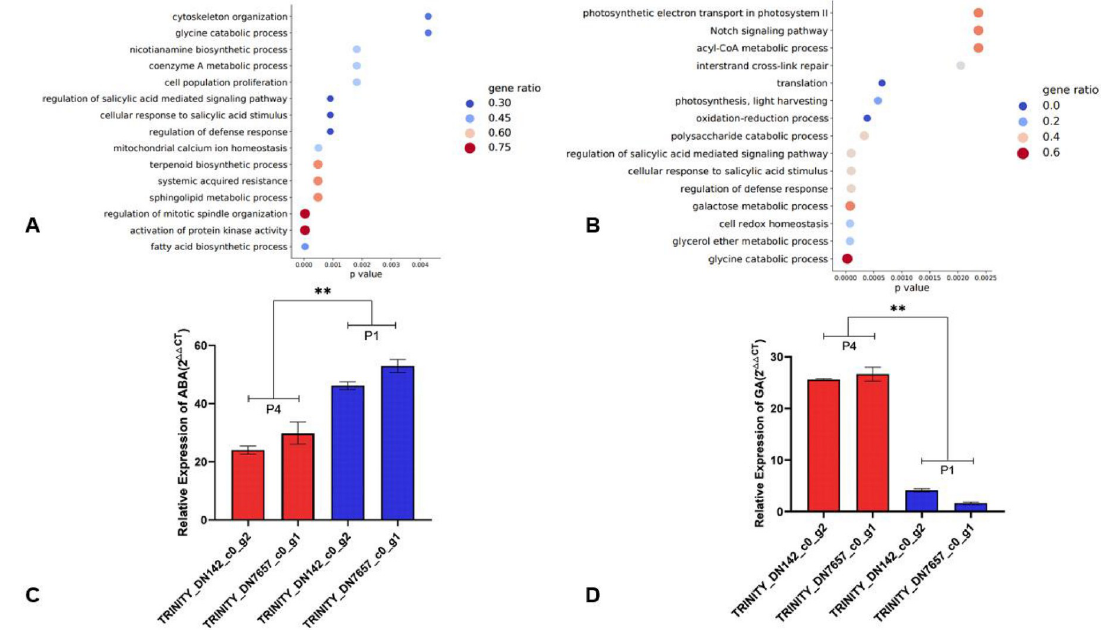
Fig 4. GO term enrichment analysis and screening of GA 3 and ABA related major regulatory genes. ( A ) and ( B ) 6281 differentially expressed genes were screened ( P < 0.05, fold-change � 1) via the Illumina RNA-Seq results of P1 (E010, E025, E015 from provenance 1) and P4 (G007, G008, G011 from provenance 4). The RNA-Seq samples (n = 9) originated from hydroponically cultivated 2-week-old seedings, which were treated with 1 μ M GA 3 and 20 μ M ABA for 24 h. The GO analysis was based on the 15 regulatory pathways that had greater significant enrichment of upregulated and downregulated genes (arranged by P -value). The abscissa represents the P -value of the different genes in this functional classification. The ordinate represents different GO function classifications. The size of the dots represents this pathway gene number in relation to the total, and the color represents the enrichment. ( C ) and ( D ) Two crosstalk genes (TRINITY_DN142_c0_g2, TRINITY_DN7657_c0_g1) between ABA and GA 3 were selected from the regulation of salicylic acid- mediated, cellular response to salicylic acid stimulus, and regulation of defense response signaling pathway. P1 (E010, E025, E015) and P4 (G007, G008, G011) were treated with flooding stress for 24 h, and the samples from each provenance were combined. The relative expression of the crosstalk genes was indicated via qPCR (2 − 44 CT ). The data are shown as means ± SD (n = 3). �� indicates significant differences ( P < 0.01) based on one-way ANOVA with multiple comparisons using